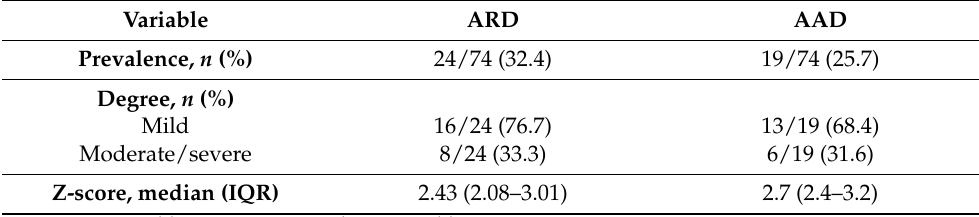
Table 2. Prevalence, Z-score and severity of ARD and AAD in 22q11.2DS